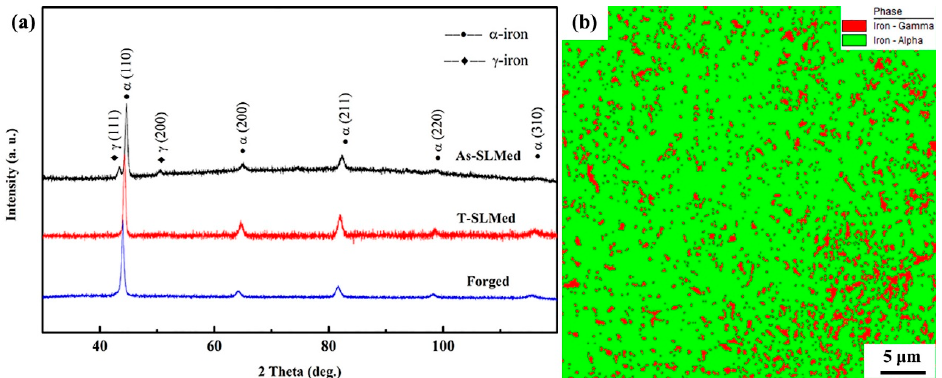
Figure 3. Phase characterization before TF tests. ( a ) XRD spectra of the as ‐ selective laser melted (As ‐ SLMed), thermally treated selective laser melted (T ‐ SLMed), and Forged H13. ( b ) Phase distribution image of the As ‐ SLMed H13 before the TF